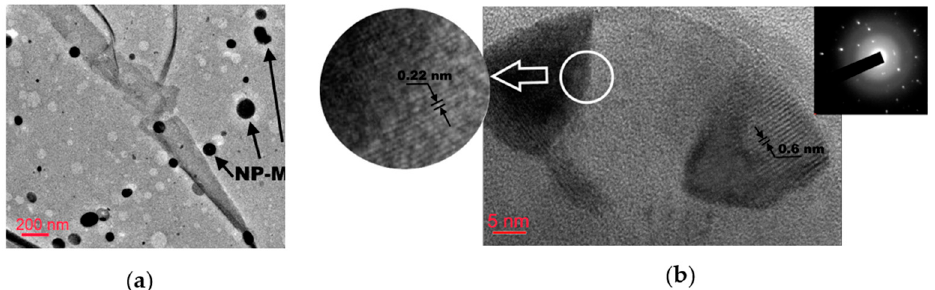
Figure 6. ( a ) TEM image of MoS x /NP-Mo thin film; ( b ) HRTEM image of Mo nanoparticle. Inserts illustrate crystalline structure of NP-Mo (left) and SAED pattern for the NP-Mo (right), which contains reflections from body-centered cubic lattice of Mo.